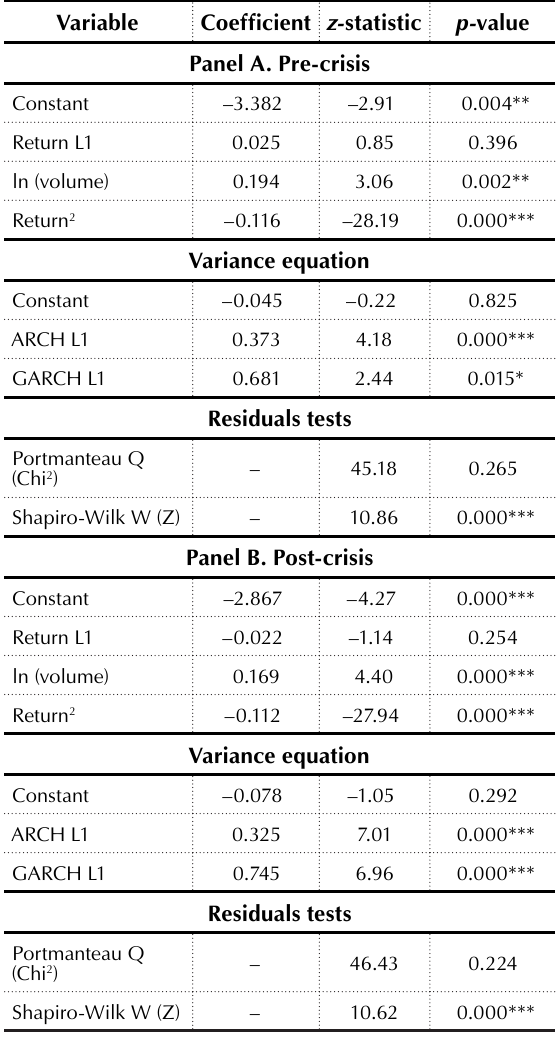
Table 7. GARCH (1,1) of volume, return